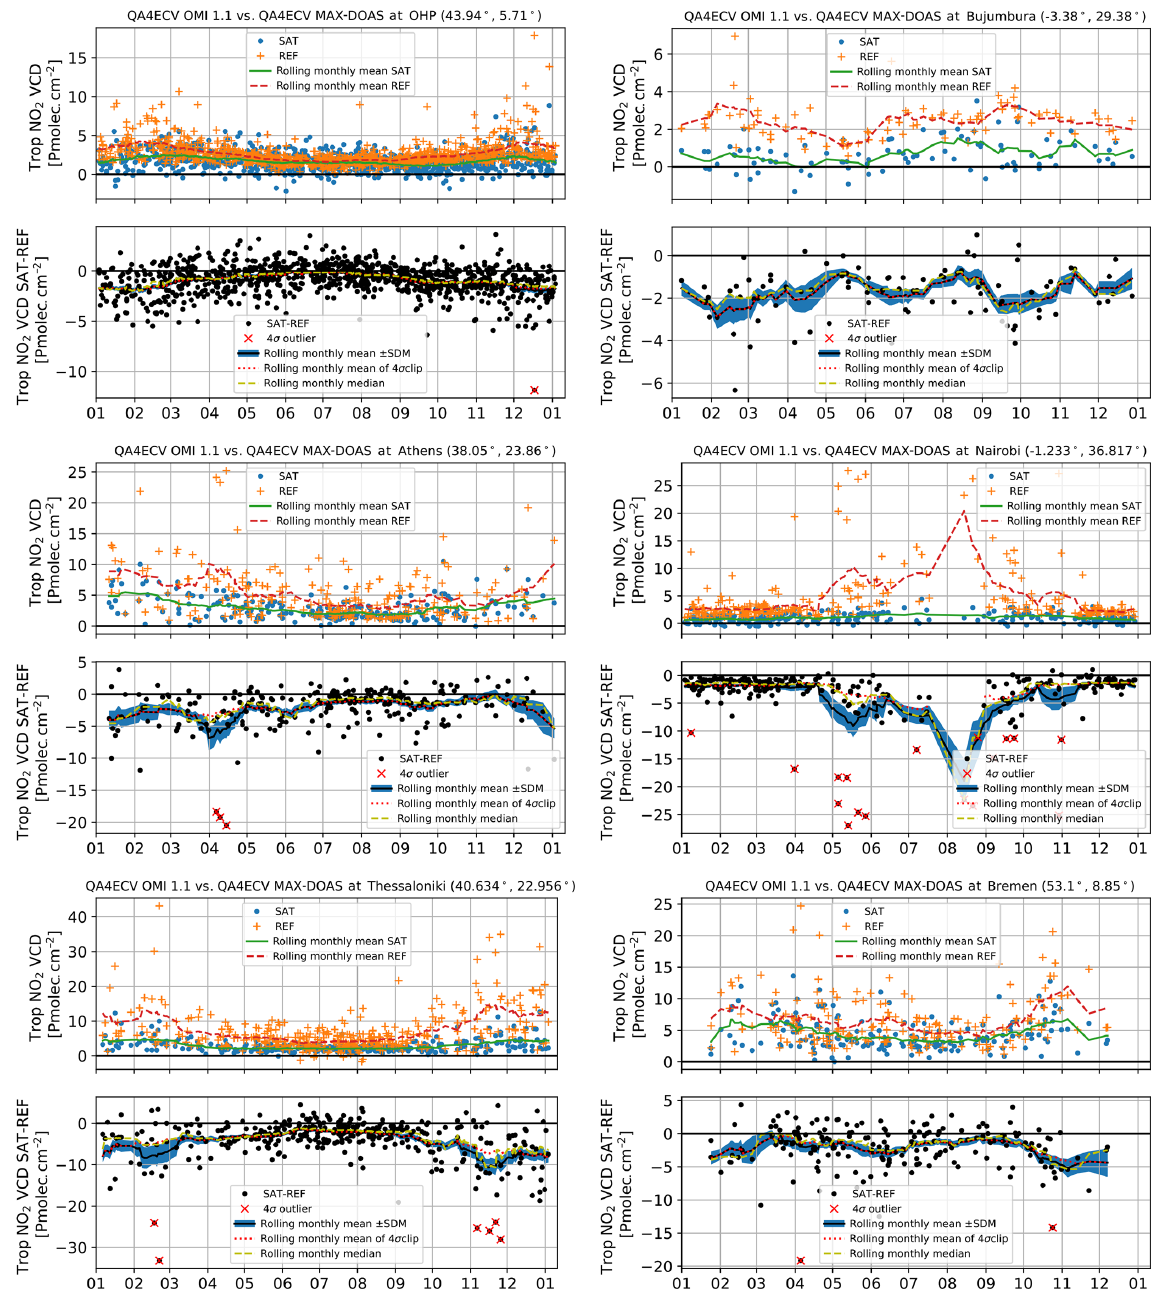
Figure 10. Seasonal cycle plots for the OHP, Bujumbura, Athens, Nairobi, Thessaloniki and Bremen sites. The top panel for each site shows the tropospheric VCD of QA4ECV OMI NO 2 and QA4ECV MAX-DOAS as well as the rolling monthly mean and median of both. The bottom panel for each site shows the differences between QA4ECV OMI NO 2 and QA4ECV MAX-DOAS, the outliers indicated by 4 σ clipping, and rolling monthly mean and median of the